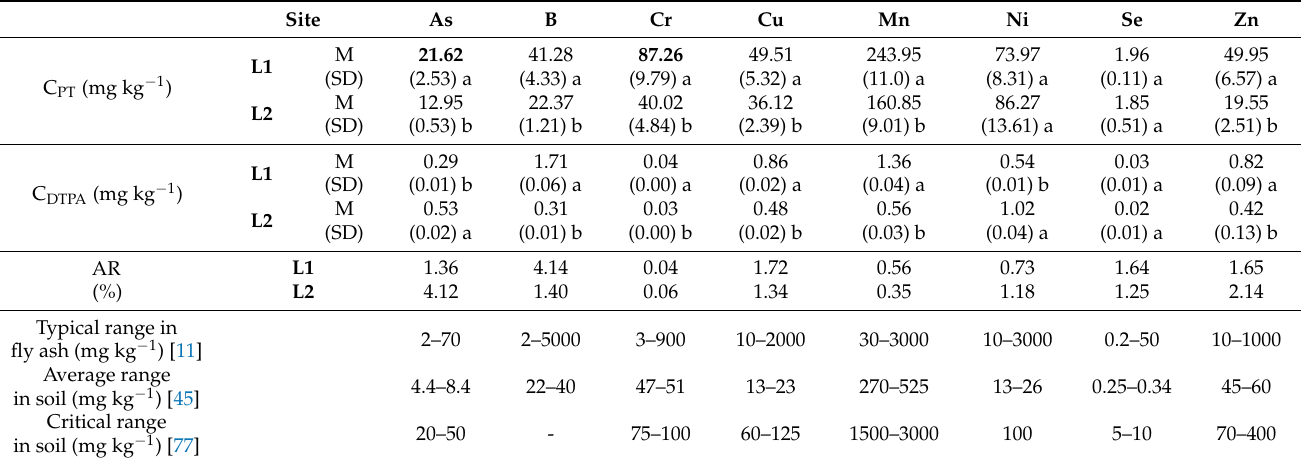
Table 2. Pseudototal concentration (C PT ), bioavailable fraction (C DTPA ), and mobility (AR) of trace elements in the surface layer (0–30 cm) of fly ash from the examined sites (L1 and L2). Site